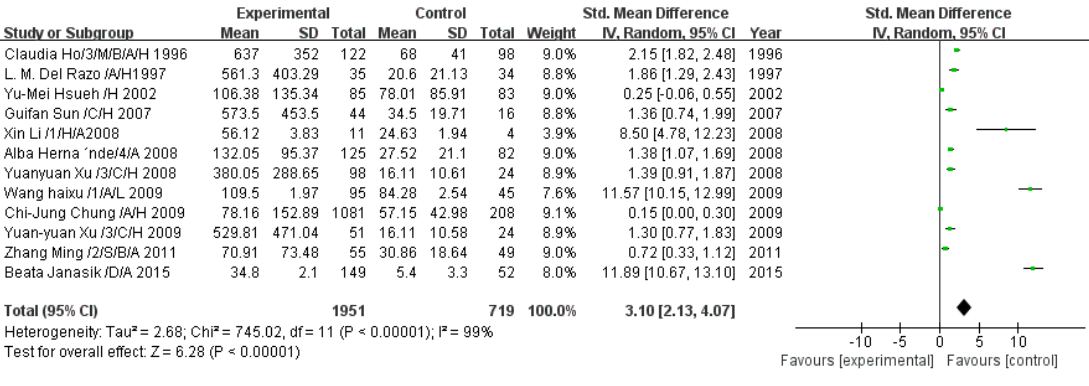
Figure 2. Effect of arsenic exposure on total arsenic (TAs) concentration in urine. Std., standardized; SD, standard deviation; IV, independent variable; CI, confidence interval.